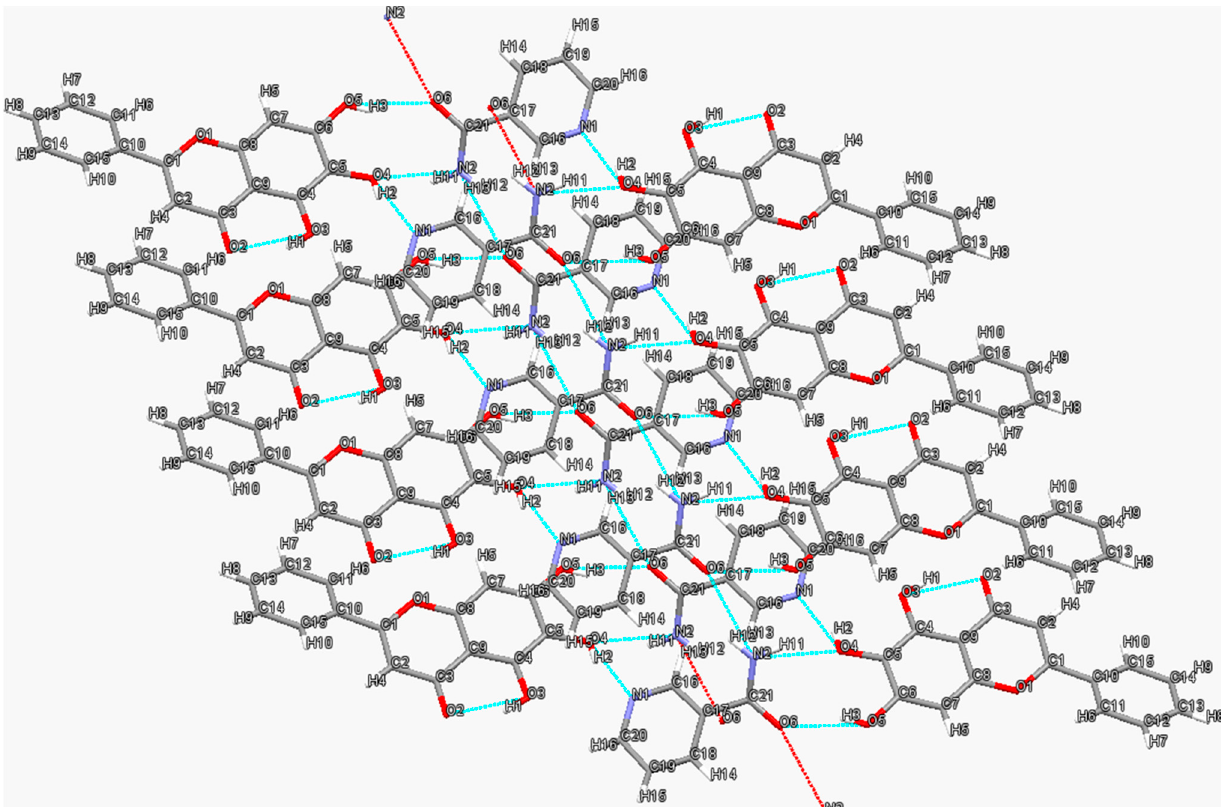
Figure 4. Two-dimensional hydrogen bonding network in baicalein-nicotinamide cocrystal. Hydro- gen bonds are represented by blue dashed lines. Red dashed lines indicate further interactions with other molecules not shown.